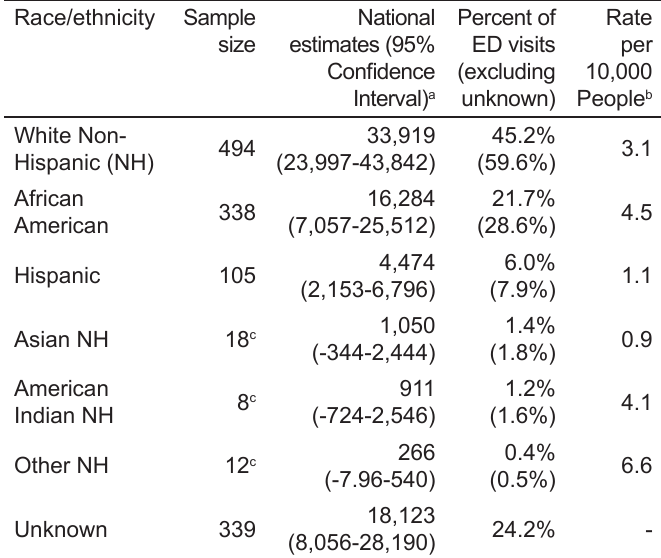
Table 6. Patient and crash characteristics of motor vehicle crash- associated eye injuries treated in U.S. emergency departments, 2001-2008.